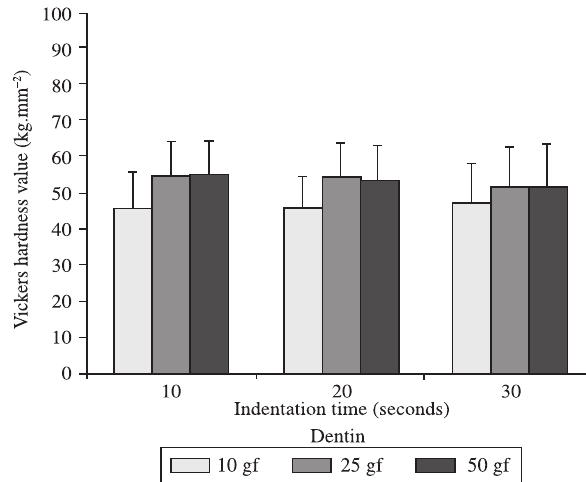
Figure 2. Average KHN values (SD) of enamel at different indentation loads and times.